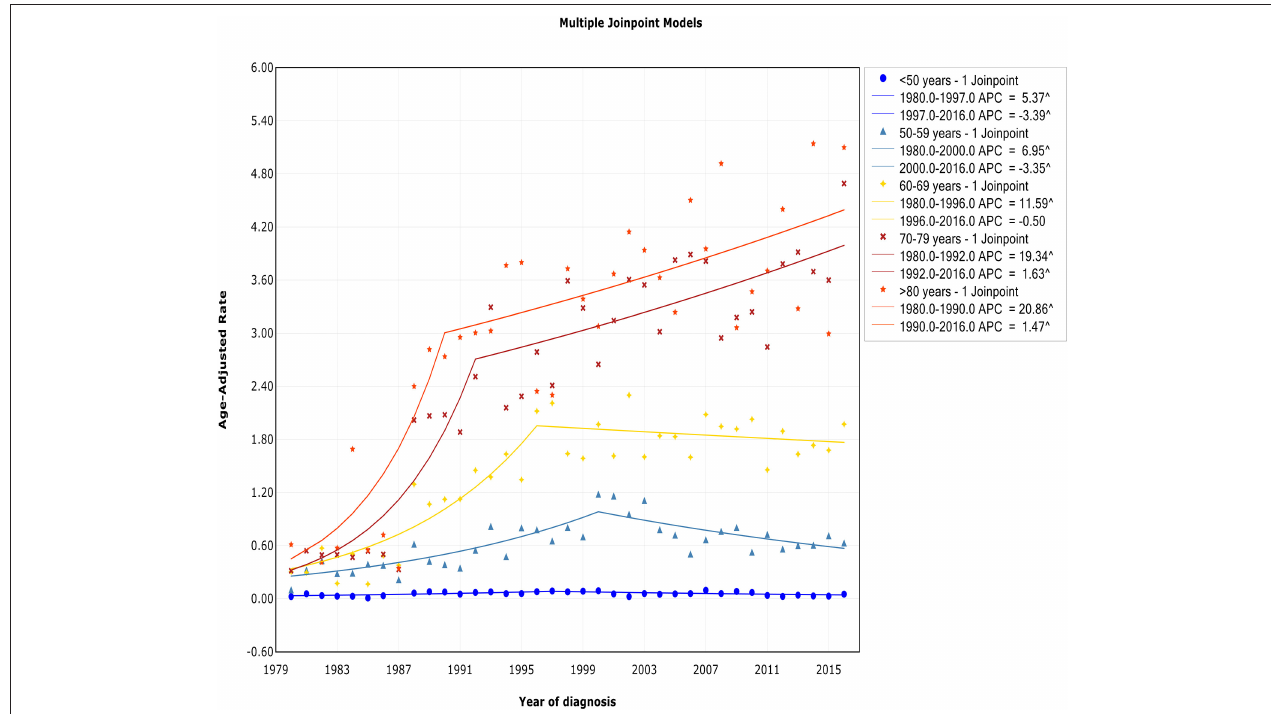
FIGURE 5 | Trends in the annual incidence of Waldenström macroglobulinemia in patients stratified according to age.